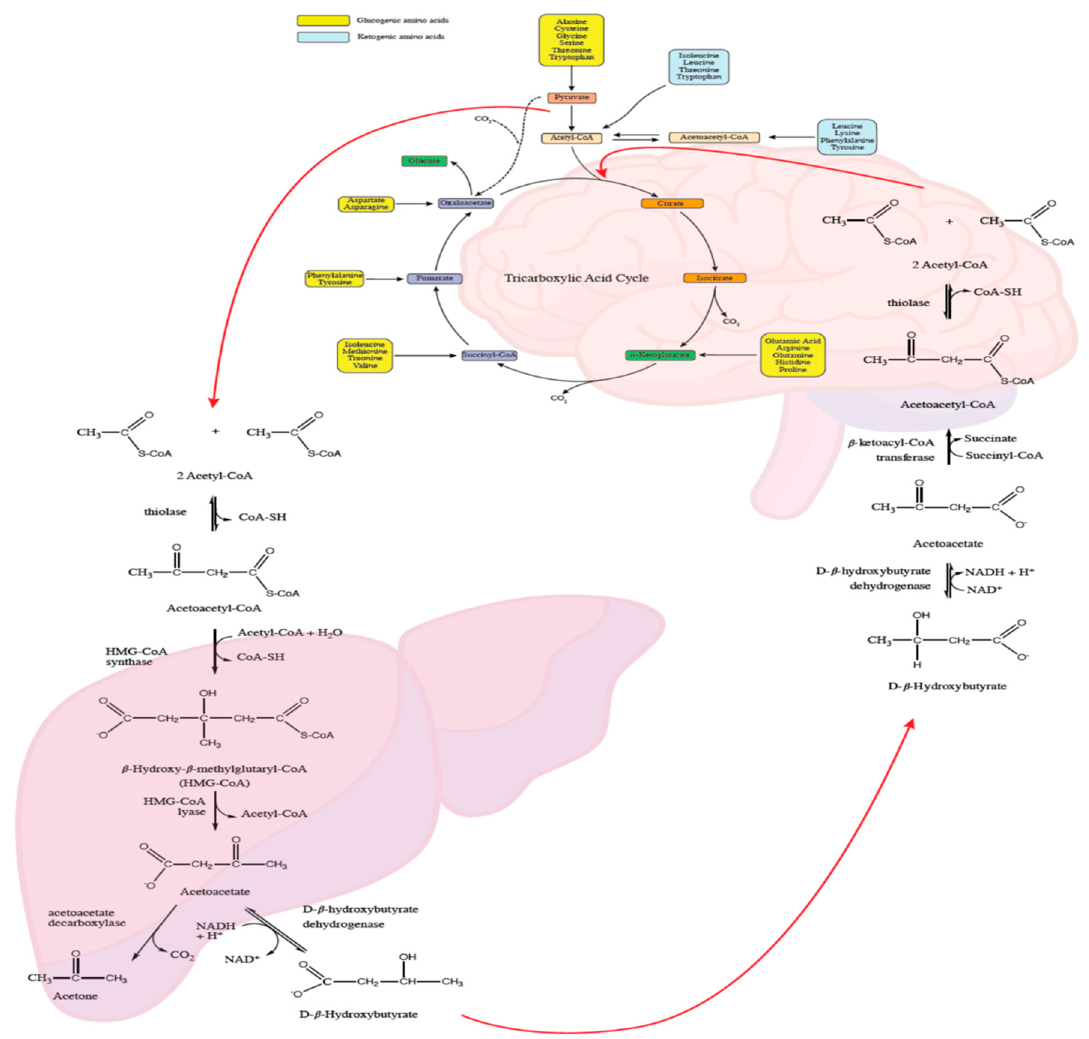
Figure 2. Biochemistry of intrahepatic ketogenesis and energy metabolism of ketones. CoA-SH = Coenzyme A; NAD + = Nicotinamide adenine dinucleotide (oxidized form); NADH = Nicotinamide adenine dinucleotide (reduced form).